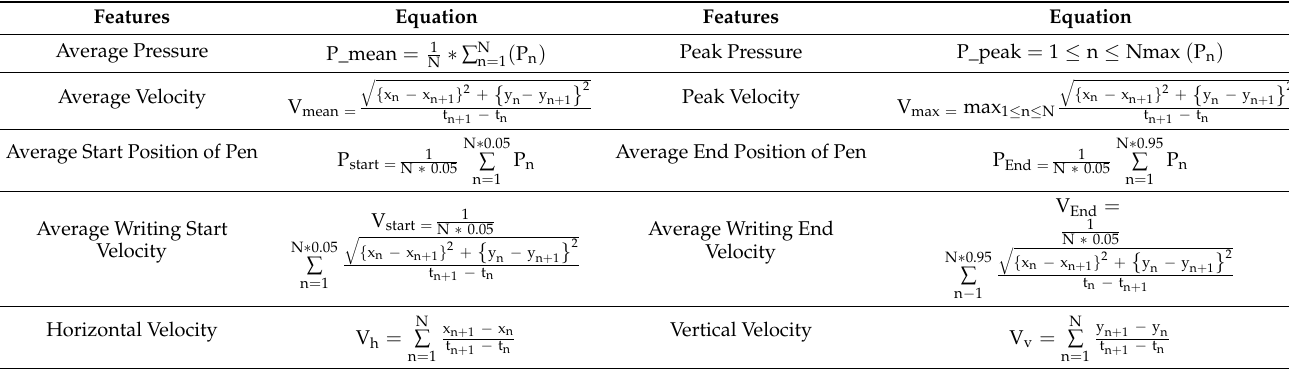
Table 3. Kinematic Features from Sensor